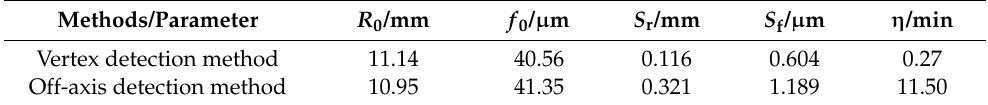
Figure 11. Graph of experimental data of vertex detection method. ( a ) Vector height error. ( b ) Relative error.